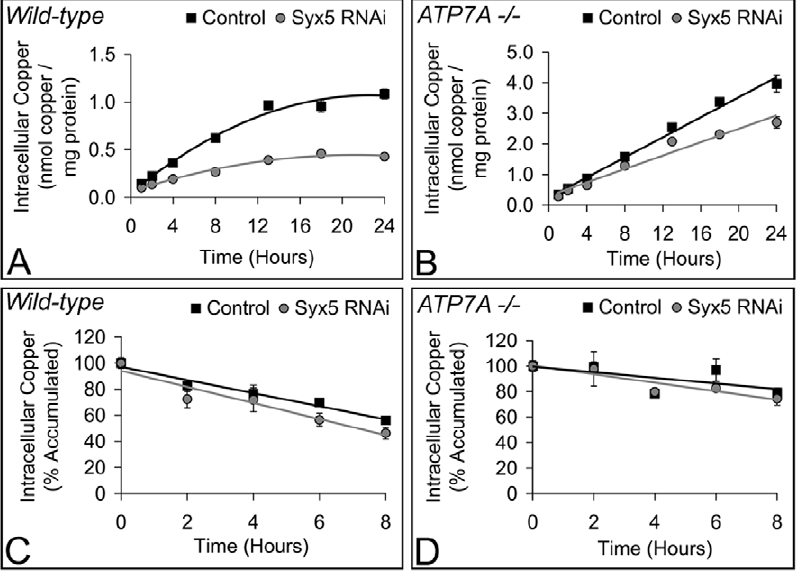
Figure 5. Syx5 suppression in human cells decreases copper accumulation but does not affect rate of turnover. Wild-type (GM2069; A) and ATP7A deficient (Me32a; B) human cell lines were exposed to control (squares) or Syx5 (circles) siRNA for 48 h. Syx5 gene expression levels relative to wild-type were 22–46% for GM2069, and 23n45% for Me32a cells. Copper accumulation was then measured with 64 Cu following 1–24 h exposure to 2 m M copper. Values are mean with s.e.m. of six replicates over two experiments. Non-linear regression analysis demonstrated copper accumulation in GM2069 cells (A) was significantly reduced following suppression of Syx5 (F=108.0, P , 0.0001). Linear regression analysis demonstrated copper accumulation was also significantly reduced in Me32a cells (B) following suppression of Syx5 (F=44.1, P , 0.0001). Rate of copper turnover of the radioisotope 64 Cu was measured in wild-type (GM2069; C) and ATP7A deficient (Me32a; D) human cell lines. Cells were treated with control (squares) or Syx5 (circles) siRNA and exposed to 2 m M copper for 24 h, then returned to basal media for 2–8 h. Data are expressed as a percentage of copper accumulation at Time 0 and expressed as mean with s.e.m. of nine replicates over three experiments. Linear regression analysis shows that the rate of copper turnover was not significantly altered by Syx5